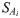
A binding mode landscape for disordered protein interactions.Residues are characterised by their binding modes to increase or decrease order upon interactions and the context-dependence of such binding modes. (A) The binding modes, reflecting the level of disorder in the bound state, are represented on the x axis; ranging from structured, well-defined to disordered, heterogeneous interactions, as quantified by the pDD values. Context-dependence, reflecting the level of fuzziness, is displayed on the y axis, ranging from stable, uniform to diverse, inducible binding modes, as quantified by the SAi values. The pDD and SAi values are predicted from the sequence by the FuzPred program. A disorder-to-order binding with low context-dependence is exemplified by a disordered loop (504–512 aa, blue squares) in Taq polymerase, which adopts a stable structure upon interacting with DNA (PDB: 3lwl [54]). A disorder-to-disorder binding with low context-dependence is represented by the heterogeneous interactions between the elongation factor AF4 (residues 747–754, orange diamonds) with leukemia fusion protein AF9 (PDB:2lm0 [55]). Fuzzy, context-depedent interactions sample a wide variety of binding modes ranging from disorder-to-order to disorder-to-disorder transitions. Context-dependent disorder-to-order binding is exemplified by the polymorphic interactions of the ribosomal S6 kinase 1 (RSK1, residues 697–703, light blue dots), which adopts different secondary structures upon binding to S100B, corresponding to autoinhibited and active forms (PDB:5csf, 5csi, 5csj [23]). Conditional folding upon binding is represented by the N-terminal region (residues 15–25, lime dots) of the large chain of ribonucleoside-diphosphate reductase, which can be structured or disordered in different oligomers (PDB: 1zyz, 1zzd [56]). Context-dependent disordered binding is exemplified by the p150 subunit of the eukaryotic initiation factor 4F (residues 225–235, light orange dots). eIF4 wraps around the translation initiation factor 4E, but the flanking region remains to be highly dynamic in the assembly (PDB: 1rf8 [57]). The interaction sites are shown by the same colours as interaction modes, and partner proteins are displayed by grey surfaces. (B) The characteristics of the different binding modes, which are represented in panel A. The binding mode landscape comprises a continuum of interaction behaviours, the major trends of which are illustrated by the distinct modes.